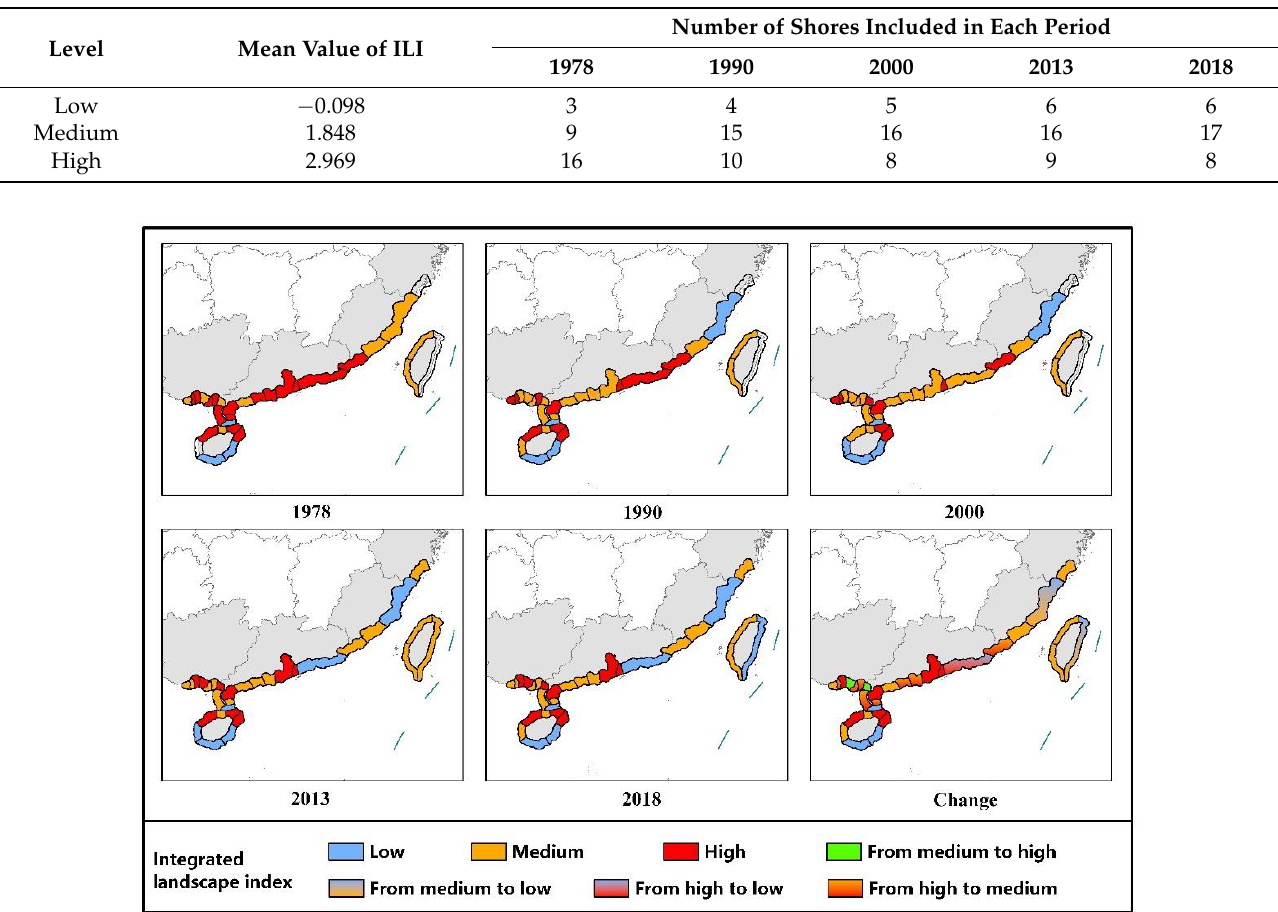
Figure 7. Temporal and spatial variations in the integrated landscape state.